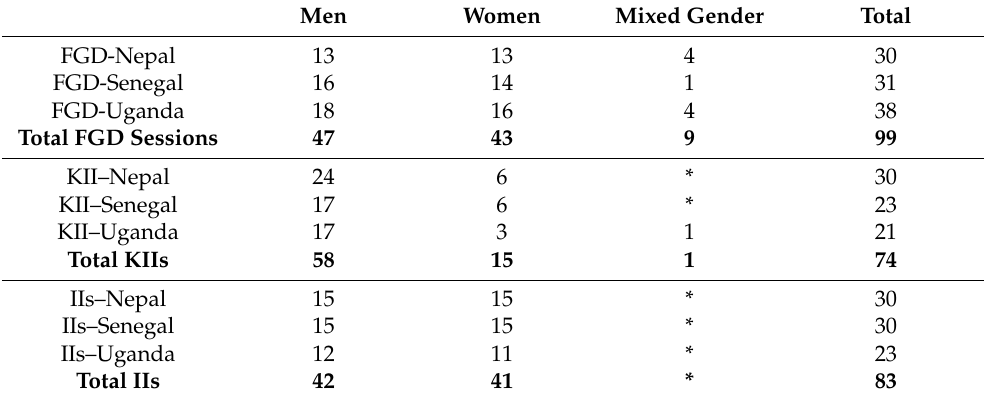
Table 1. Breakdown of qualitative instruments used in fieldwork, by gender and country *.